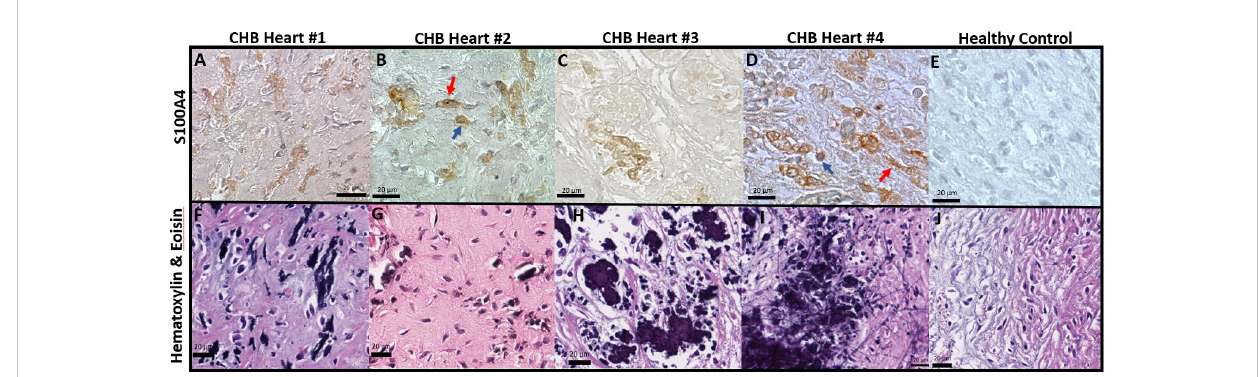
FIGURE 1 Histological features of end-stage cardiac-NL include S100A4 + macrophages and fi broblasts at areas with dystrophic calci fi cation in the injured hearts. Human fetal hearts of offspring of 4 women enrolled in the RRNL were evaluated for pathology fi ndings. Panels (A-E) are stains of AV nodal tissue from CHB Heart 1, CHB Heart 2,CHB Heart 3, CHB Heart 4 (Table 1), and an age-matched healthy control heart respectively. H&E staining of fetal heart tissue of the CHB cases (F-I) revealed properties in common include disruption to AV node and conduction tissue architecture associated with foci of dystrophic calci fi cation. As expected, H&E staining of the healthy control heart (J) depicted normal nodal tissue unaffected by calci fi cation. S100A4 + immunostains were evident at dense packs of cells (brown cells, A-D ) surrounding microcalci fi cation foci (F-I) . S100A4 + macrophage (plump sphere, blue arrow) and fi broblast (spindle-shaped, red arrow) identity was assigned on the basis of cell morphology (B, D)